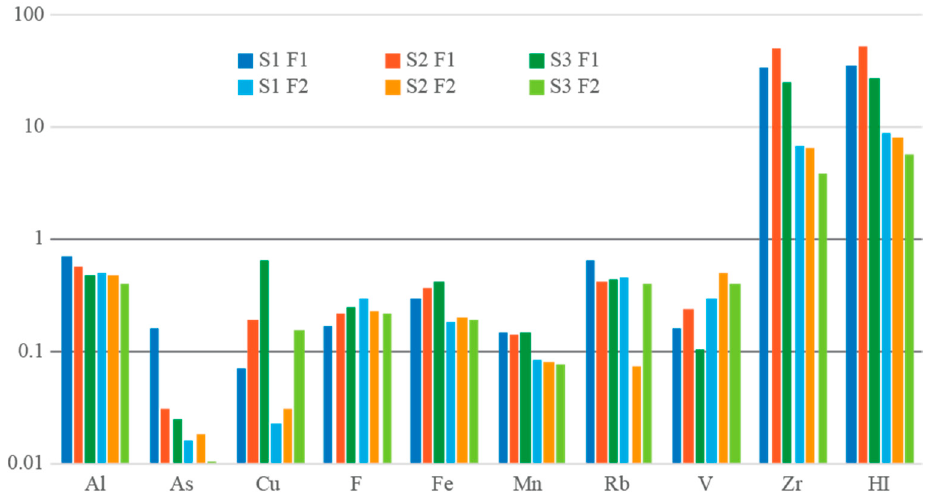
Figure 4. Non-carcinogenic chronic hazard quotient ( HQ ) of Al, As, Cu, F, Fe, Mn, Rb, V and Zr by ingestion in children and cumulative non-carcinogenic hazard index ( HI ). Logarithmic scale.